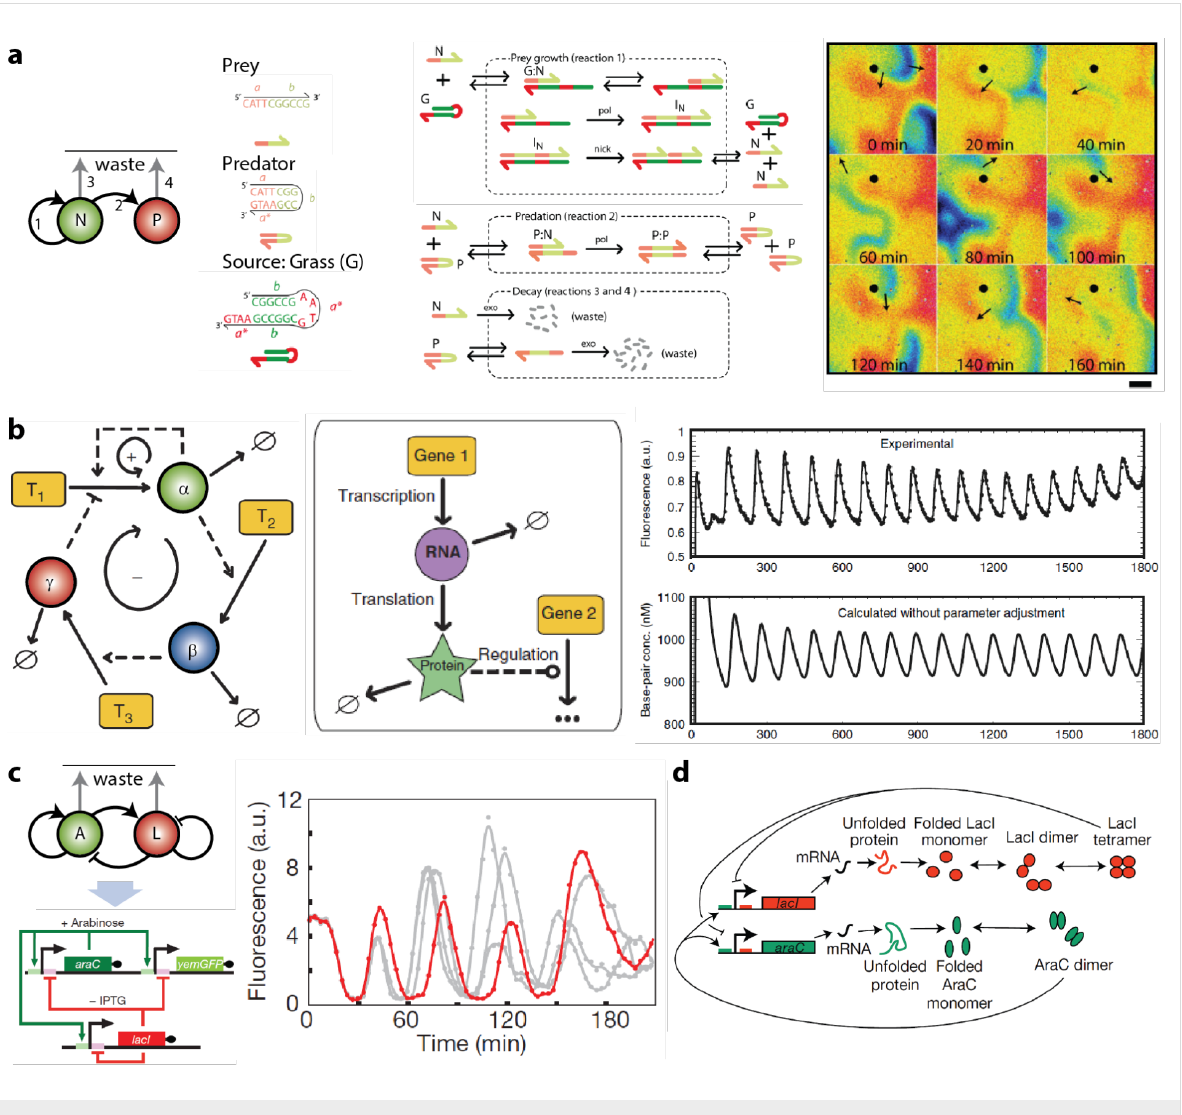
Figure 4: Design principles applied in synthetic biology. (a) Network topology, mechanism, and the clockwise-rotating spiral of the prey in the molecu- lar predator–prey network. Adapted with permission from [88], copyright 2013 American Chemical Society. (b) The gene regulation pathway and of an oscillator based on a positive and delayed negative feedback motif, with experimentally observed oscillations shown to be in good agreement with the simulations. Adapted with permission from [90], copyright 2011 the authors. (c) Oscillations in the dual-feedback motif. (d) Illustration of the explicit intermediate processes required for accurate simulations in the mathematical modelling of genetic reaction networks. Adapted with permission from [91], copyright 2008 Nature Publishing